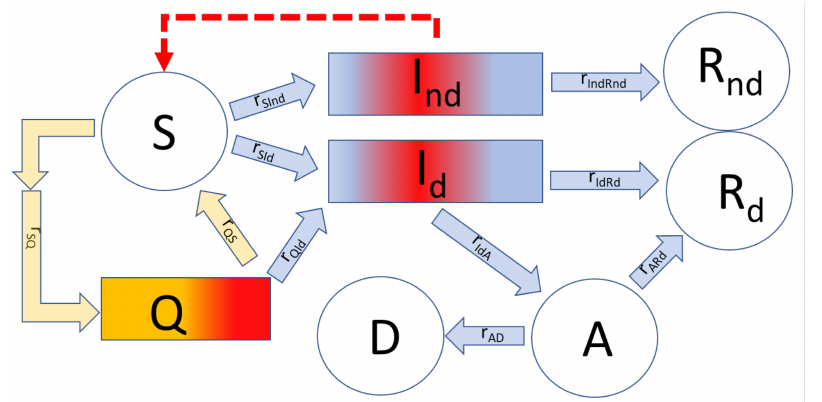
Figure 6. Integrated scheme of the infection units model including the quarantine pool, Q . The main associated parameter is the number of isolated individuals per one confirmed infected, w